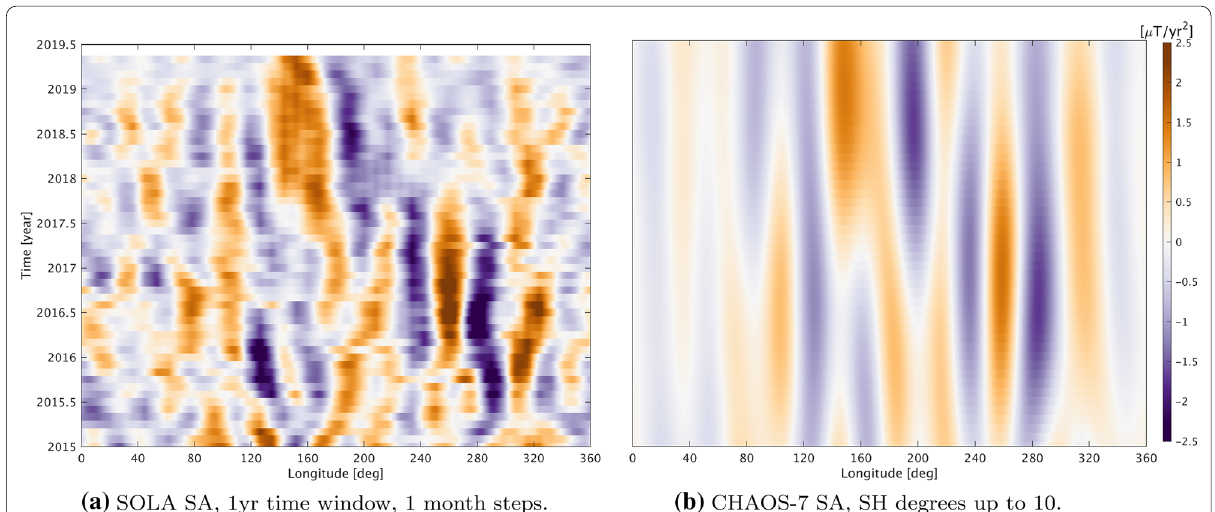
Fig. 10 Time–longitude plots along the geographical equator at the CMB, showing: 1-year differences of SOLA SV estimates derived from 1-year data windows moving in 1-month steps (left), and SA predictions from the CHAOS-7.2 model for SH degrees n ∈ [ 1,10 ]